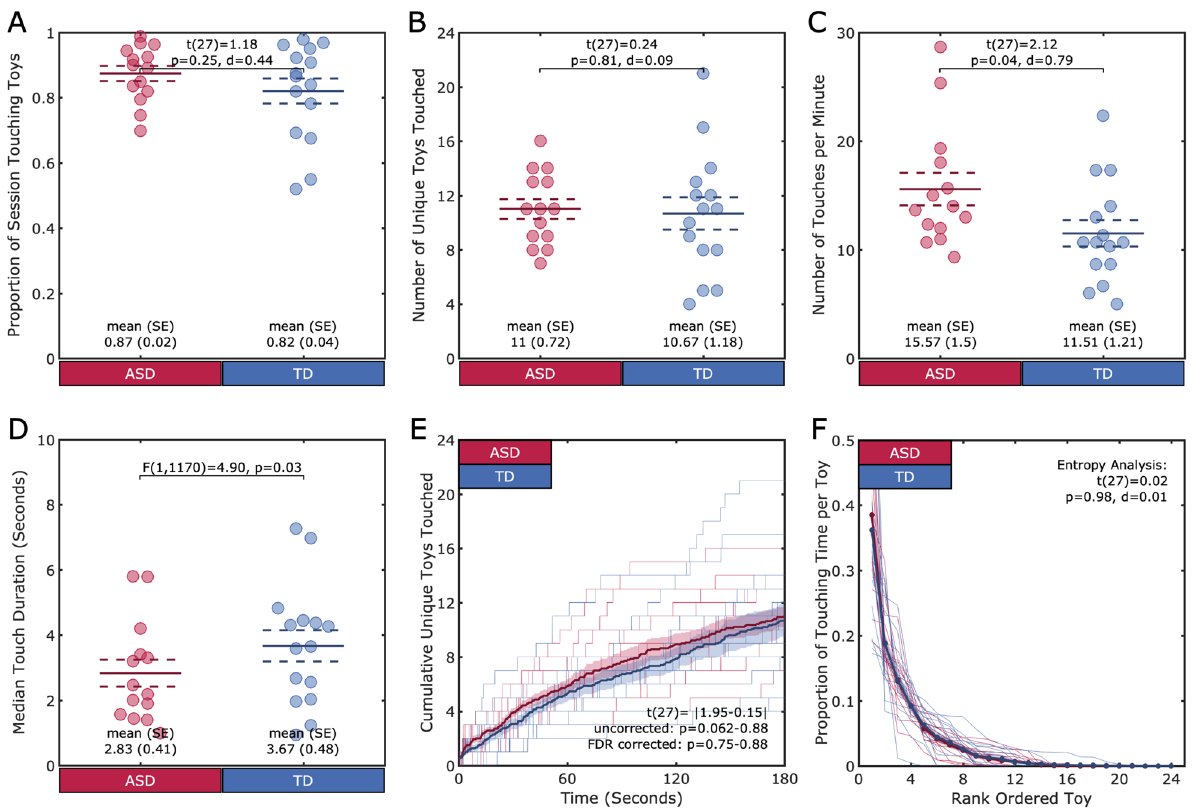
Figure 3. Manual Action. ( A – D ) Each individual is represented by a circle. The group mean is represented by the solid line, and the standard error is represented by the dotted lines. ( A ). Groups did not differ on the proportion of the play session that each child spent manually acting on toys. ( B ) Groups did not differ on the number of unique toys (in the set of 24) that each child manually acted upon. ( C ) Children with ASD generated more manual actions on toys per minute compared to their TD peers and ( D ) they generated shorter actions. ( E – F ) Each individual is represented by a thin line. The bold lines represent the group means, and the shaded region represents the standard error. ( E ) The x-axis is the session time in seconds, and the y-axis is the cumulative unique number of manually acted upon toys. There were no differences between groups in the rate of manually acting on previously un-acted on toys. ( F ). The x-axis is the rank ordered toy and the y-axis is the proportion of the session spent manually acting on that toy. There were no differences between groups in the amount of the session spent manually acting on any of the toys, in rank